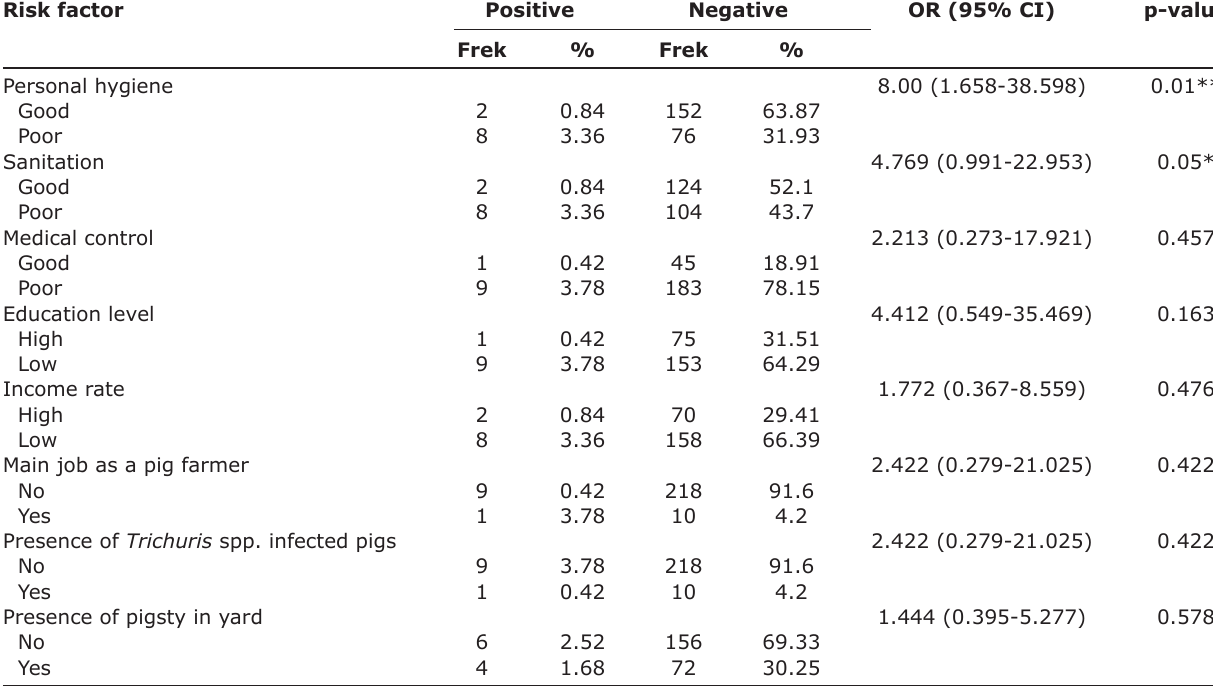
Table-6: Risk factor of Trichuris spp. infection in traditional pig farmers in Bali. Risk